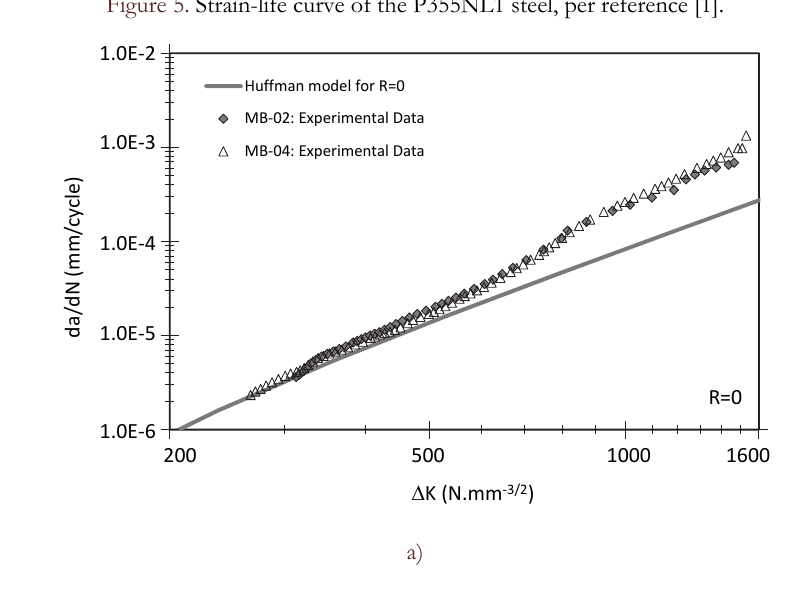
Figure 5. Strain-life curve of the P355NL1 steel, per reference